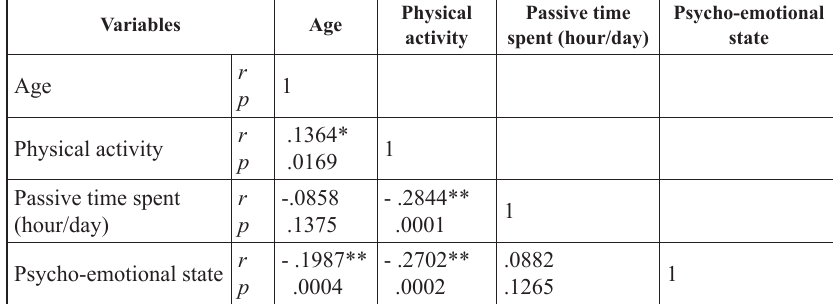
Figure 5. Respondents’ identified measures to reduce stress and/or anxiety their total physical activity level increased ( r = .1364, p < .05). A negative correlation was also discovered between the passive time spent by the respondents and physical activity – the higher Table 1. Correlation between respondents’ age, physical activity, psycho-emotional state the physical activity, the shorter the sedentary and the amount of time spent sitting time ( r = - .2844, p < .01). Variables Table 1. Correlation between respon- dents’ age, physical activity, psycho- emotional state and the amount of time spent sitting